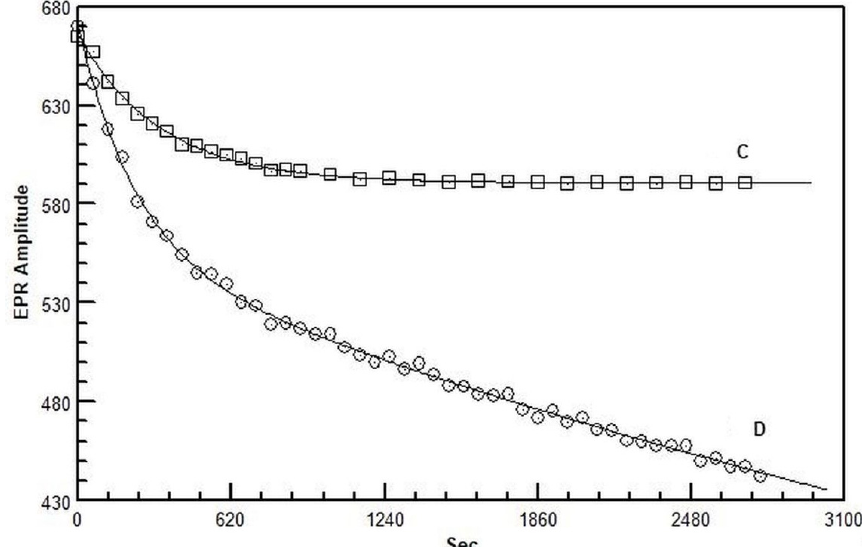
Figure 2. EPR decay kinetics of 1,1-diphenyl-2-picrylhydrazyl (DPPH•) obtained from berry extracts from control and defoliated vines of Vitis vinifera (Trebbiano variety). C, control; D, defoliated.